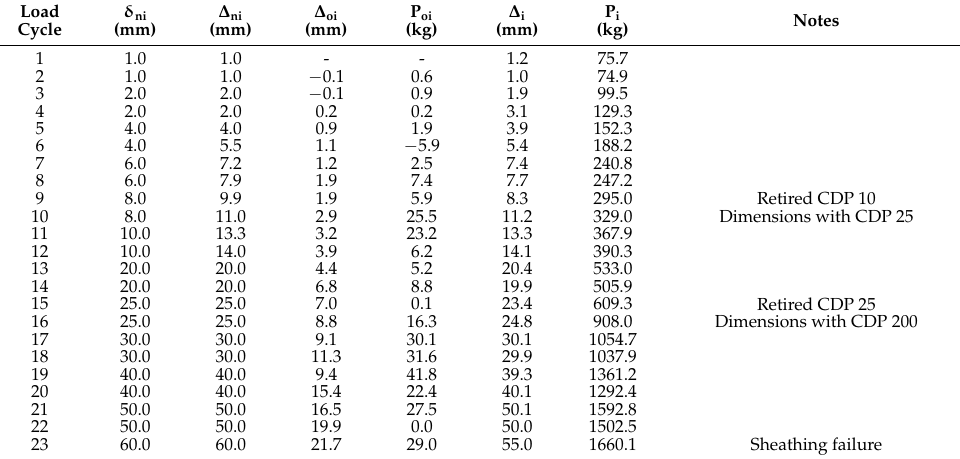
Table 4. Record of the shifting and loads on the experiment